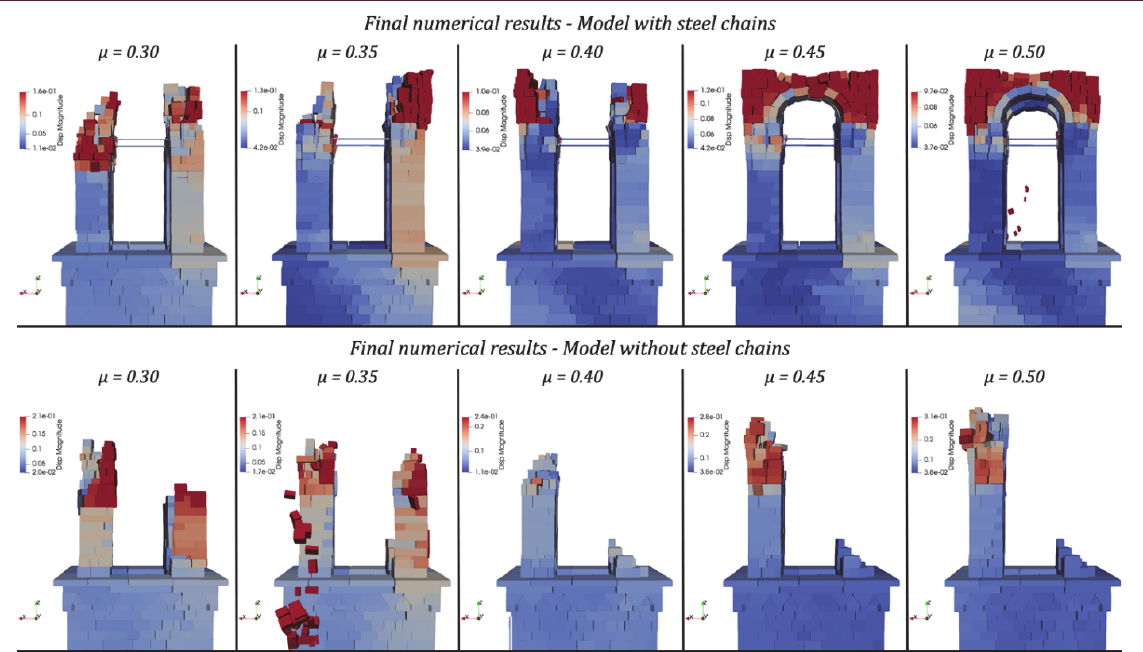
Figure 15: Numerical cumulative damages of the civic clock tower of Amatrice (Rieti, Italy) under the four main shocks recorded in the village during the Central Italy seismic sequence of 2016 for both configurations, with and without the steel chains, at varying of the friction on the bell